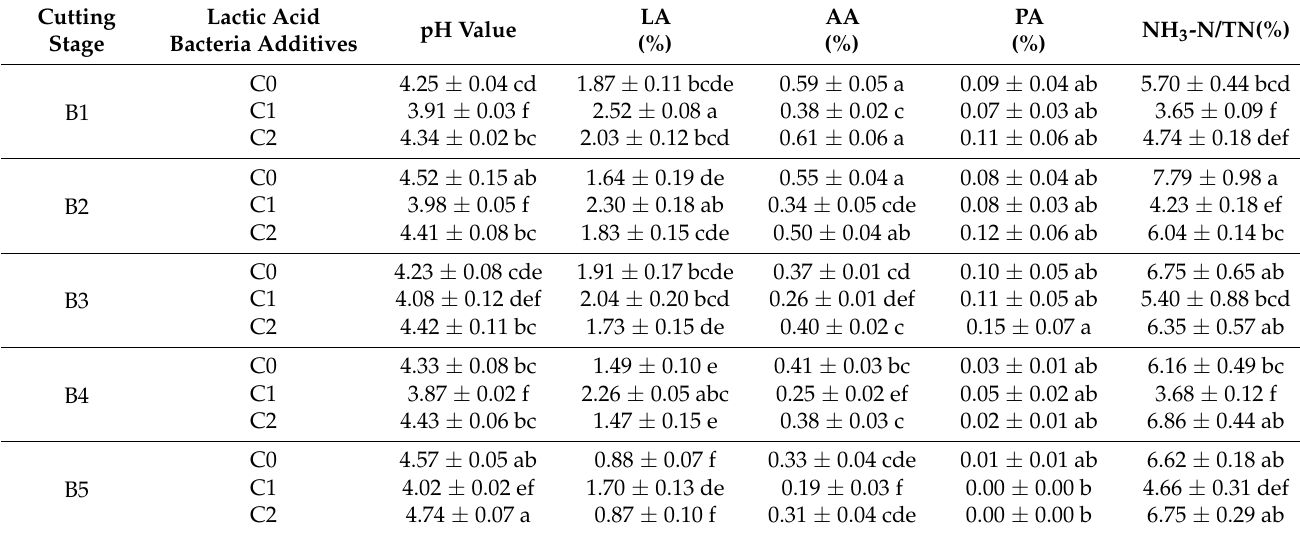
Table 5. Differences in the average fermentation quality for the interaction between cutting stage and lactic acid bacteria